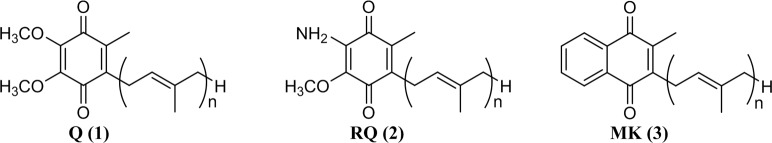
Structures of ubiquinone, rhodoquinone and menaquinone.The number of isoprene units (n) in the tail varies by species from 6–10. The reduction potentials of the quinones are as follows: Q, E°′ = +100 mV; RQ, E°′ = −63 mV; MK, E°′ = −80 mV.